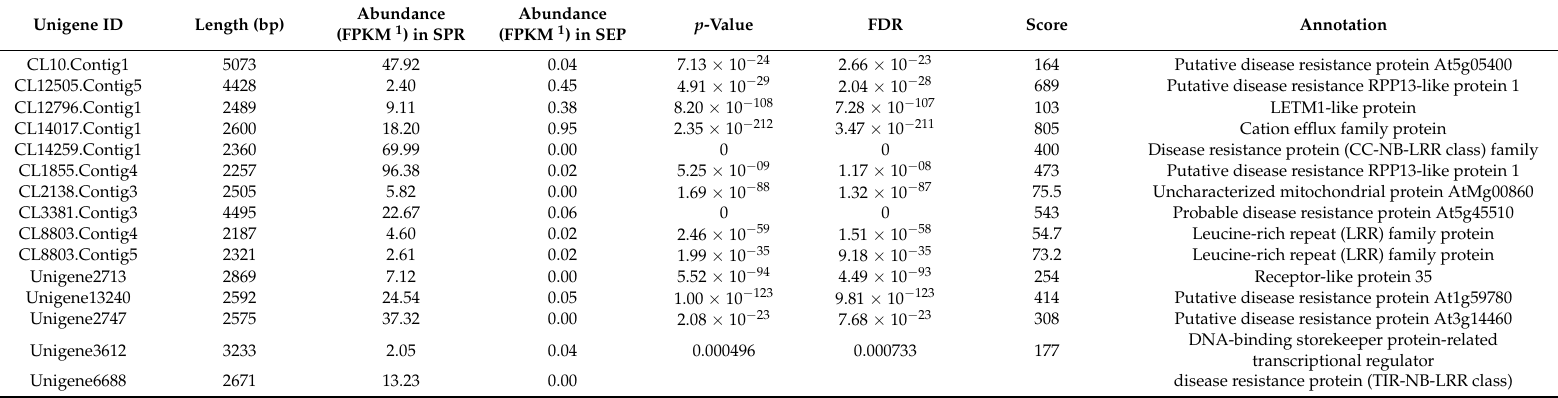
1 FPKM: Fragments per kilobase of transcripts per million mapped